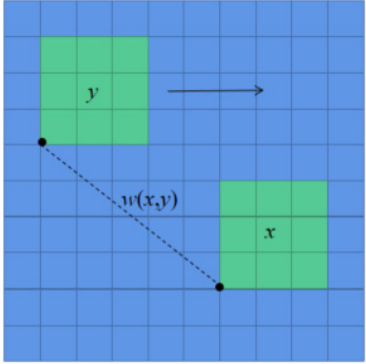
Figure 4. Schematic diagram of non-local mean filter.